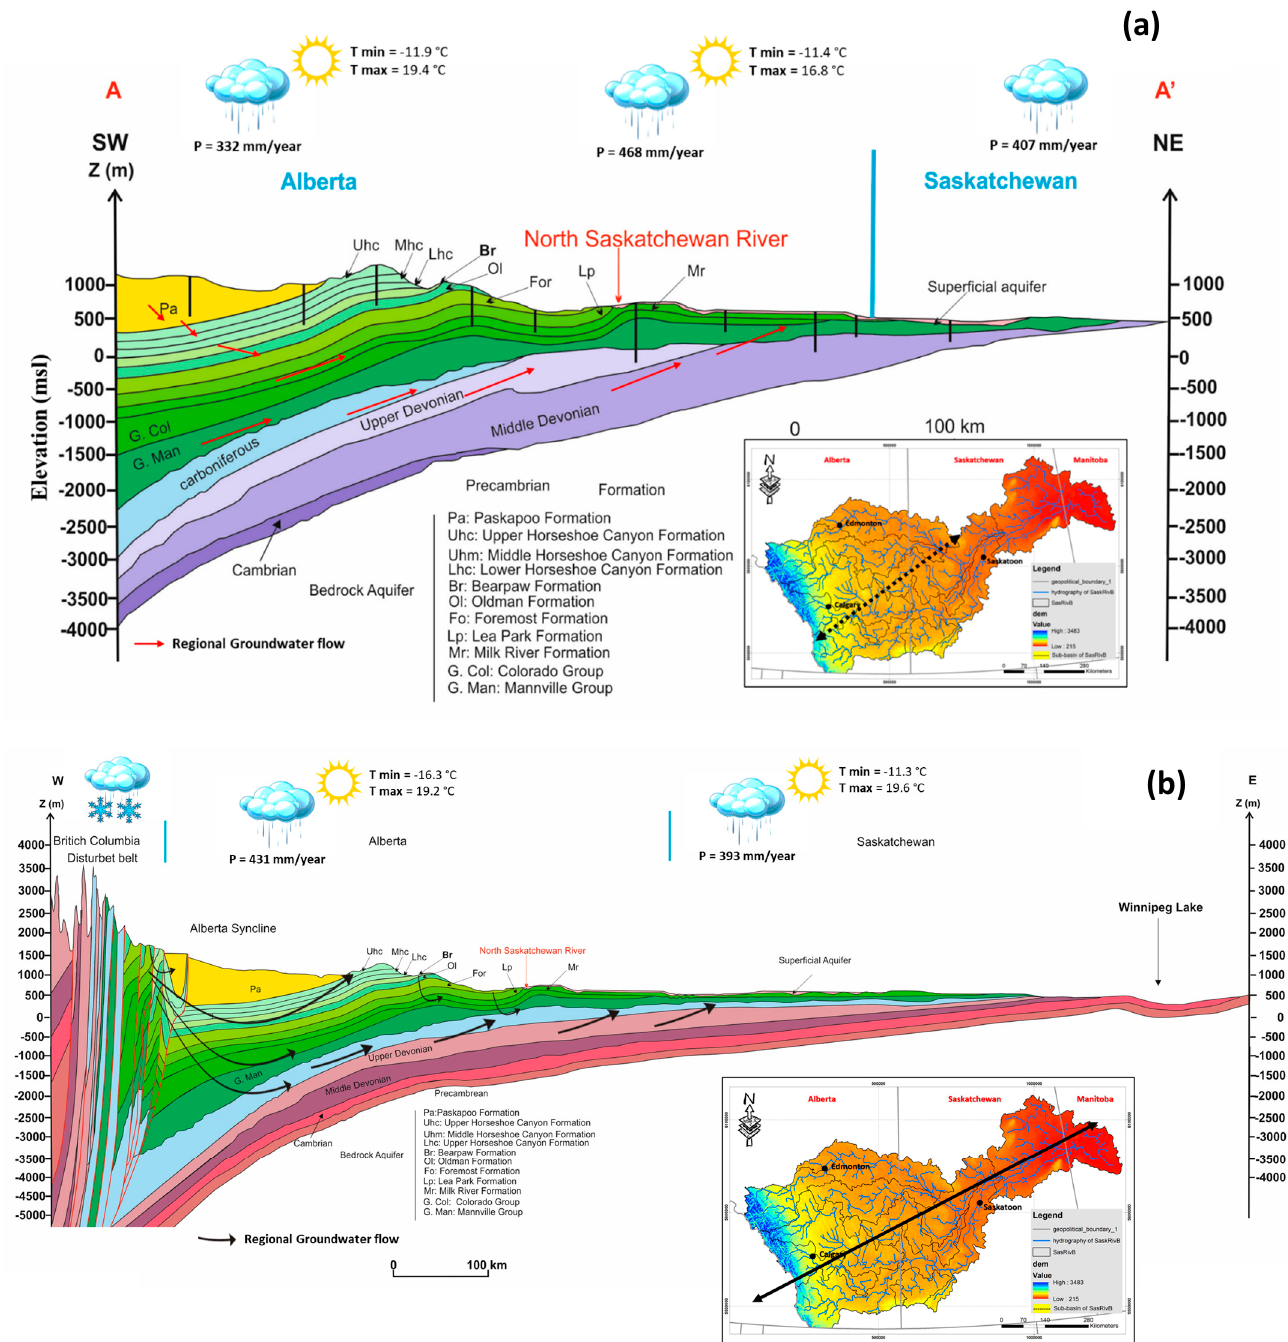
Figure 8. Hydrogeological conceptual model (SW-NE transect) of the Saskatchewan River Basin. P indicates annual precipitation.